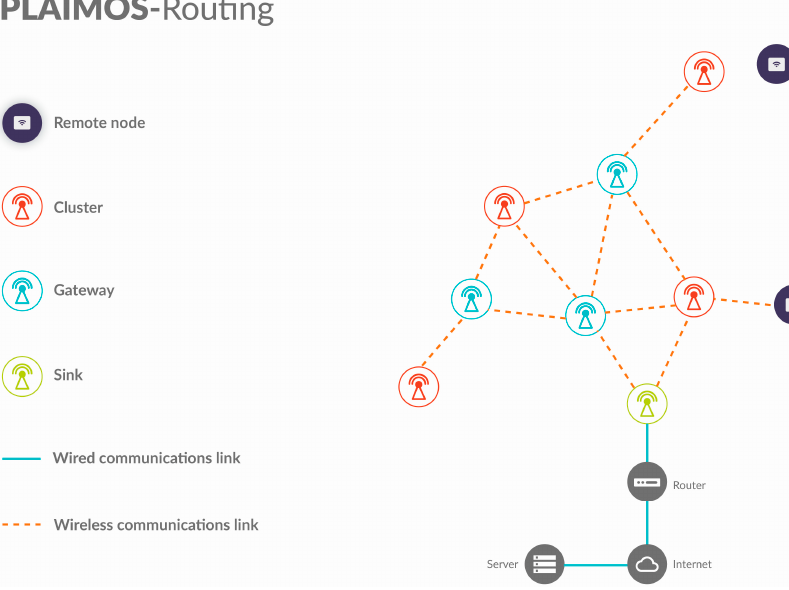
Figure 16. PlaIMoS-Routing. Figure 16.